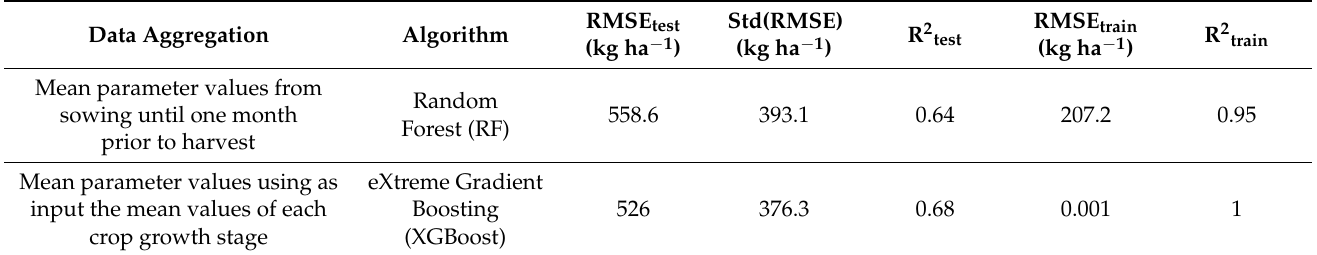
Table 4. Statistical evaluation of yield estimates with the best-performing ML algorithms for parcels in the region of Larisa (n =